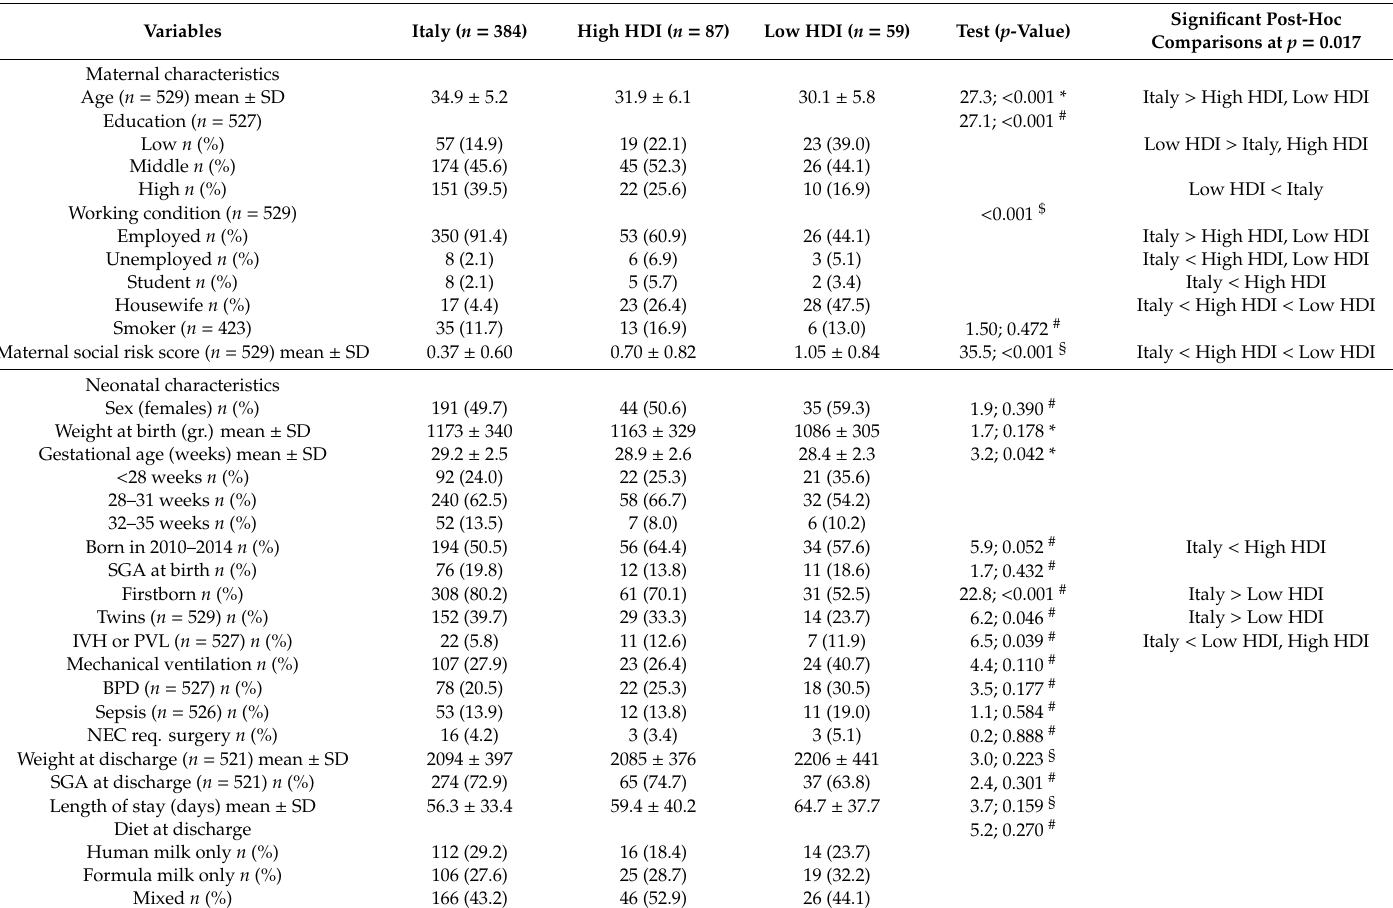
Table 1. Characteristics of the study population by mothers’